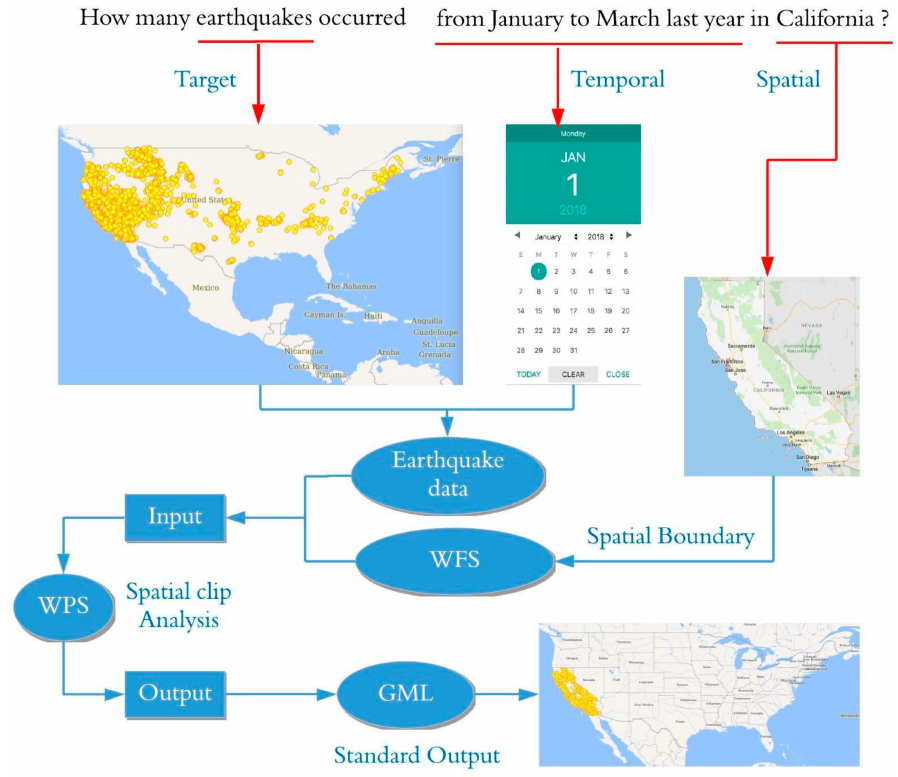
Figure 1. A natural disaster use case—an inquiry about the occurrence of earthquakes in